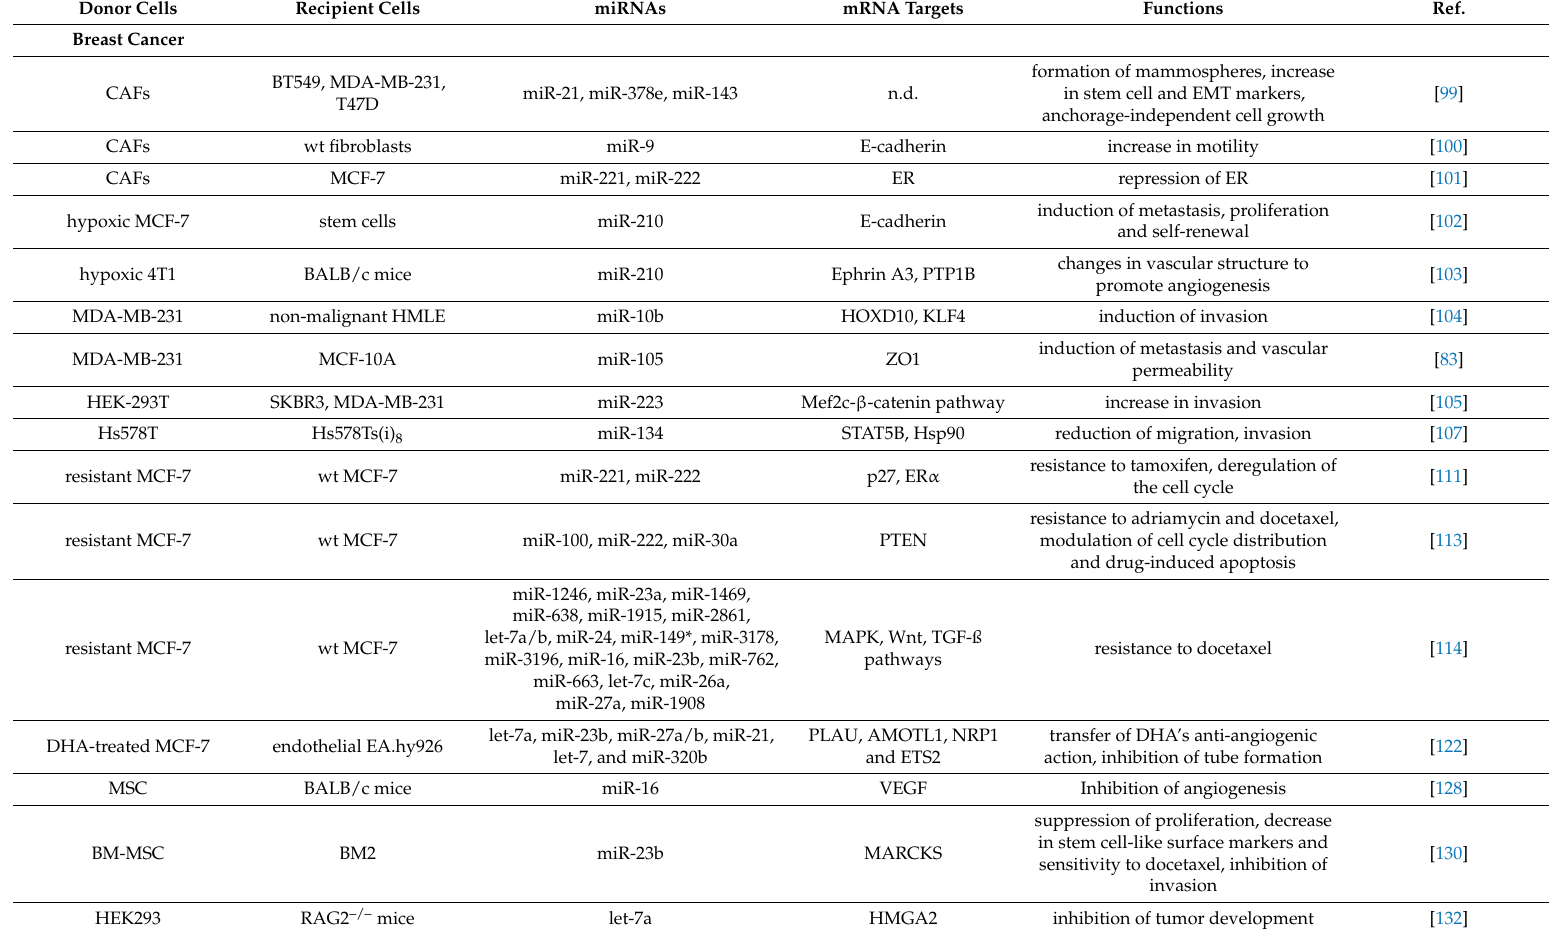
Table 1. Exosome shuttle from cell to